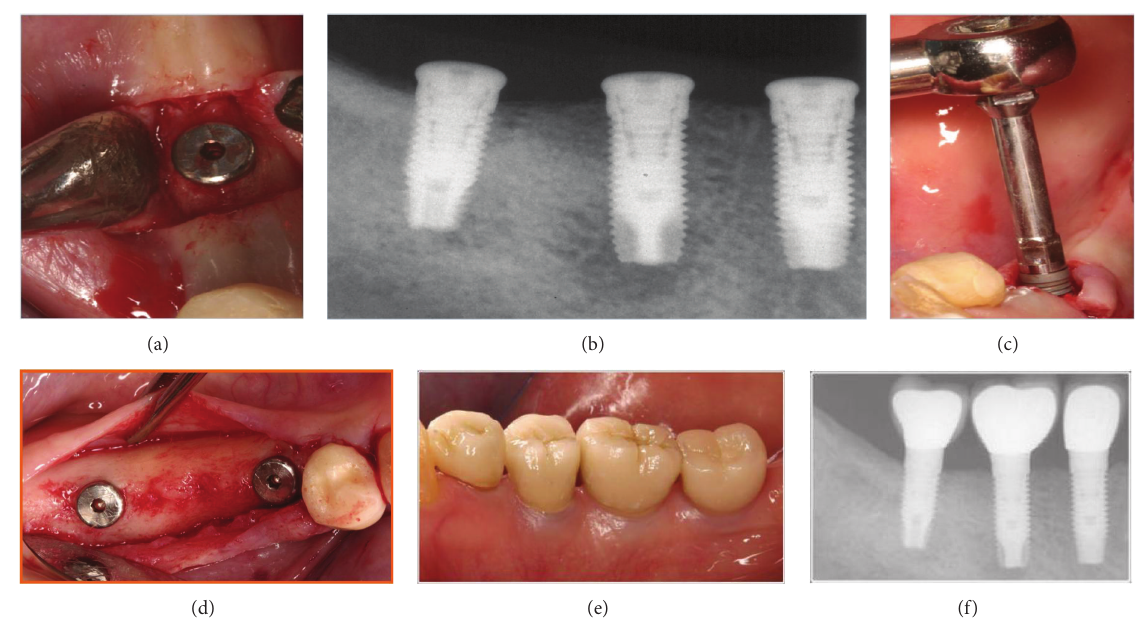
Figure 3: Explantation of dental